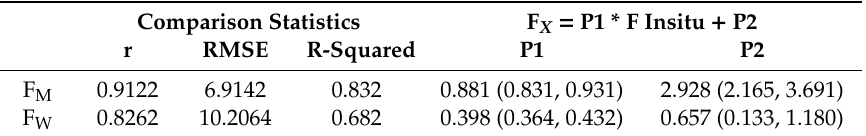
Table 3. Results of the comparison between direct measurements and calculated fluxes. r is Pearson’s correlation coefficient, RMSE is root mean square error, and R-squared is the coefficient of determination. The equation that better fits the relationship with in situ fluxes with slope P1 and intercept P2 is shown with 95% confidence bounds in parentheses.